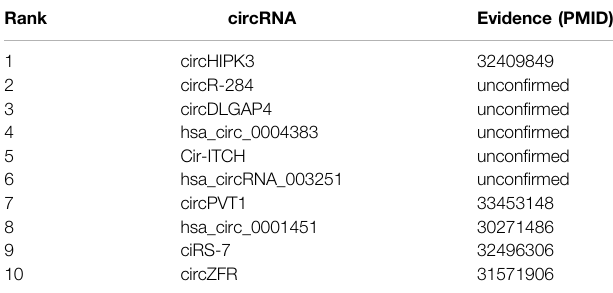
TABLE 4 | Top 10 candidate circRNAs related to prostate cancer.